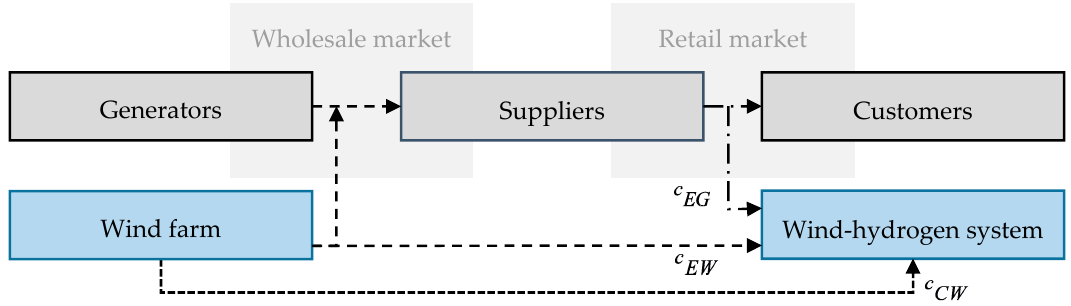
Figure 3. Electricity prices in the wind-hydrogen system.